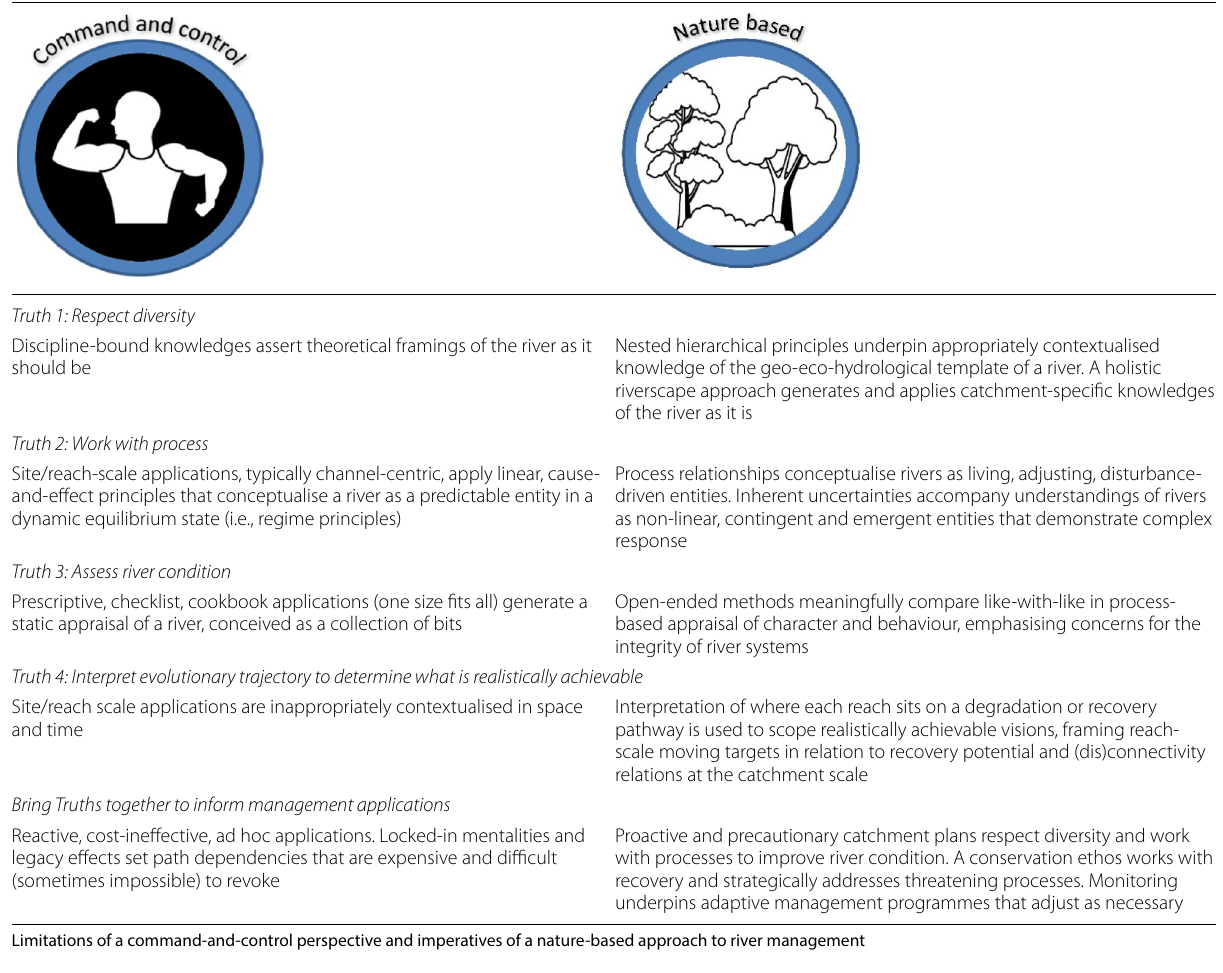
Table 1 Truths of the